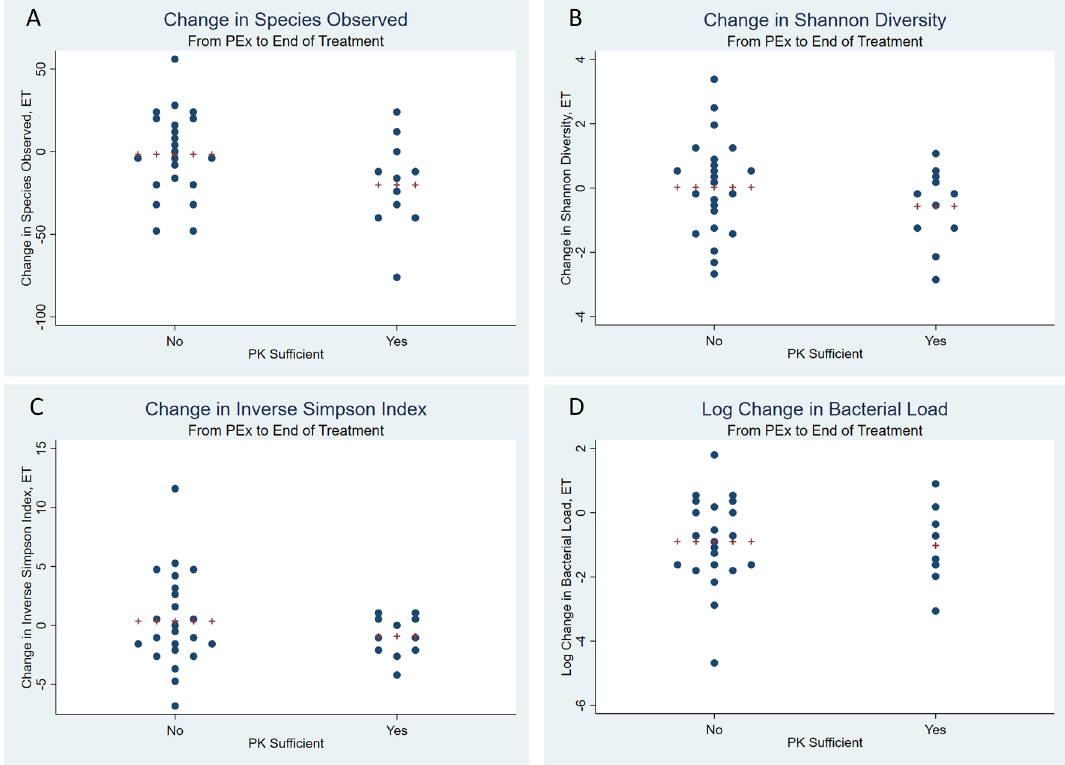
Figure 1. Change in alpha diversity and bacterial load by beta-lactam pharmacokinetic exposure from pulmonary exacerbation to end of antibiotic treatment. Panel ( A ) Change in Species Observed. Panel ( B ) Change in Shannon Diversity. Panel ( C ) Change in Inverse Simpson Index. Panel ( D ) Log Change in Bacterial Load. PK, pharmacokinetics; PEx, pulmonary exacerbation; E, pulmonary exacerbation; T, end of treatment; ET, change between pulmonary exacerbation and end of treatment. Plus signs represent the